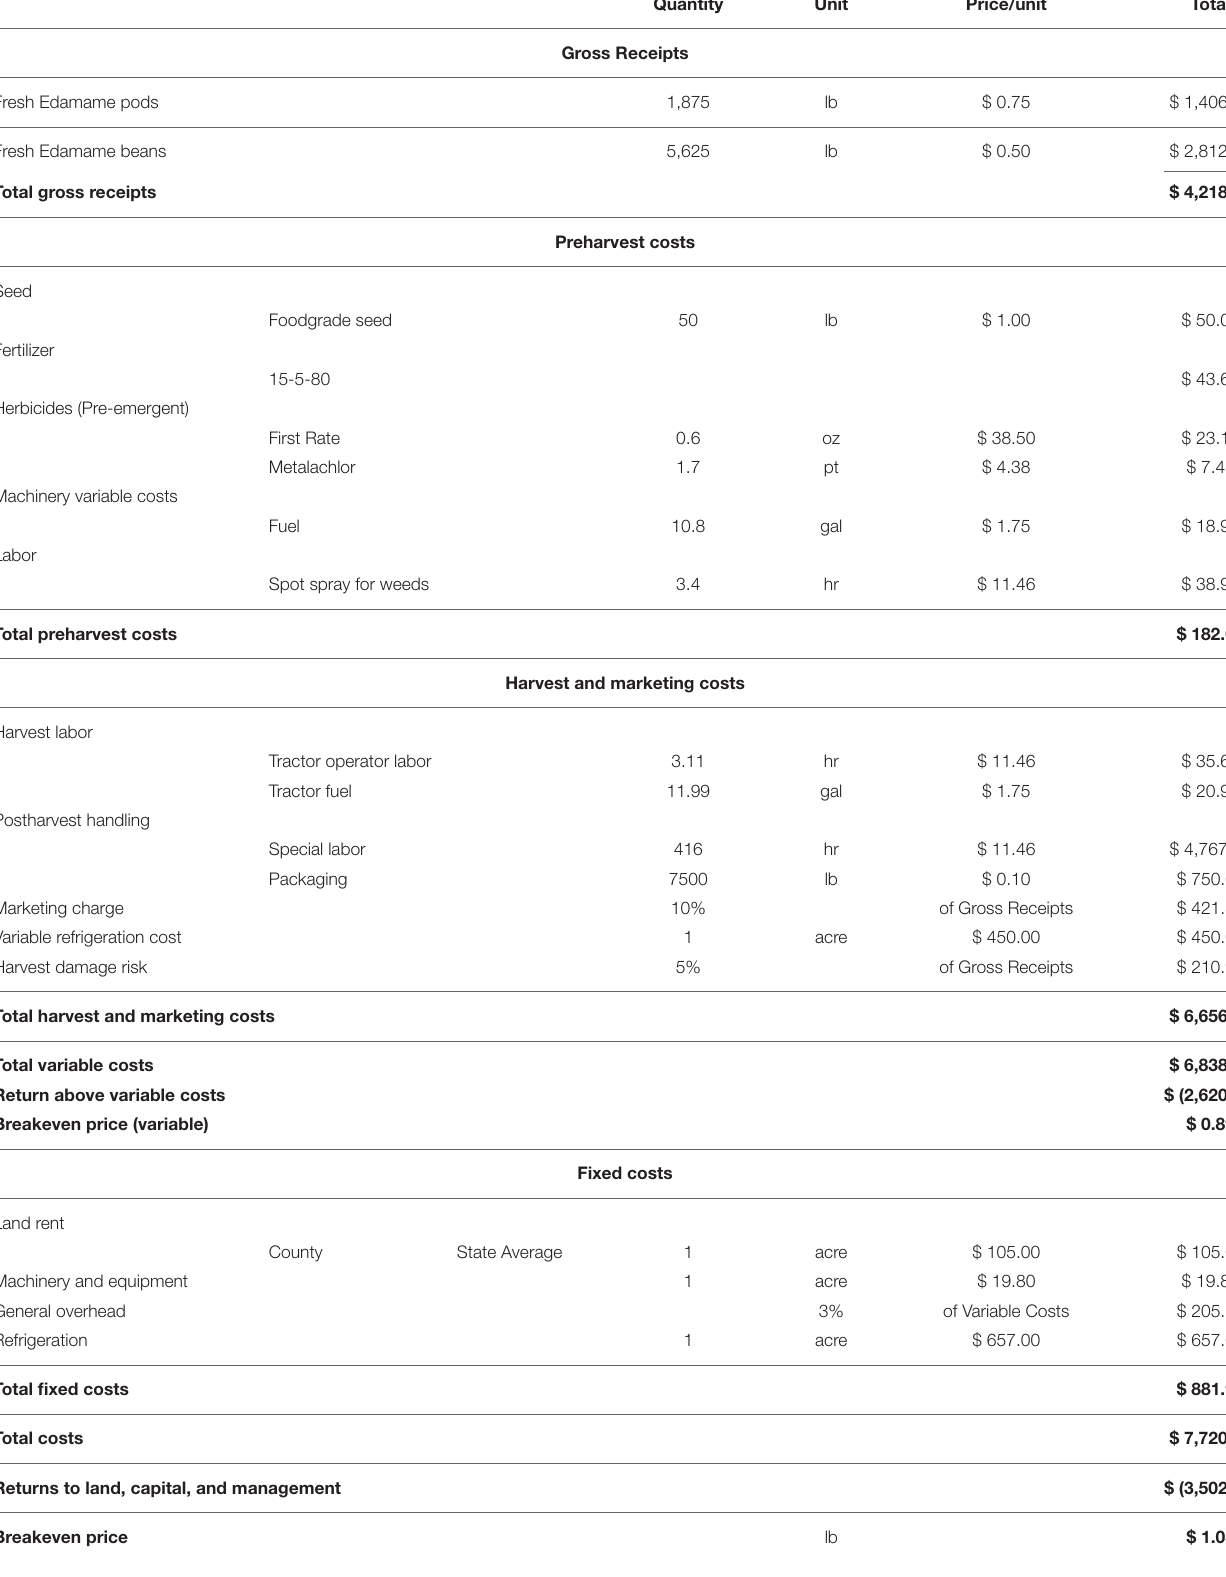
TABLE 1 | Enterprise Budget for Average Farm in Virginia—Edamame, hand-harvested (Source: Garber et al., 2019). Quantity Unit Price/unit